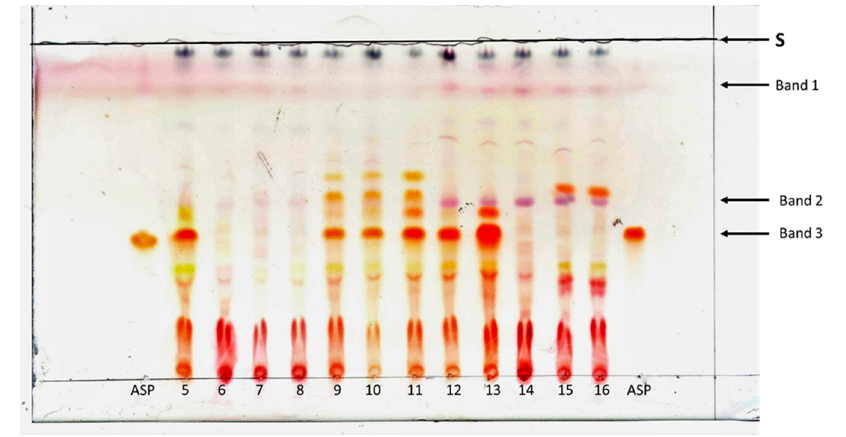
Figure 4. TLC analyses conducted on 12 wild-growing rooibos ecotypes representing different A. linearis growth types. An acidifier was included which significantly reduced tailing of the bands. Asp: aspalathin standard, S: solvent front.